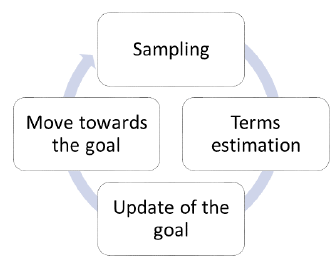
Figure 1. The global structure of STE algorithm using a mobile